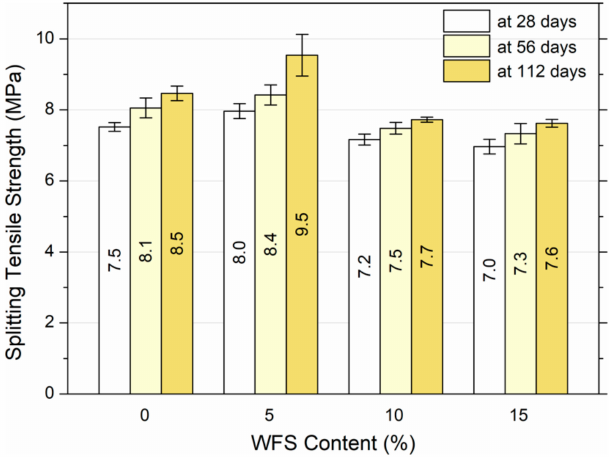
Figure 3. Splitting tensile strength results.